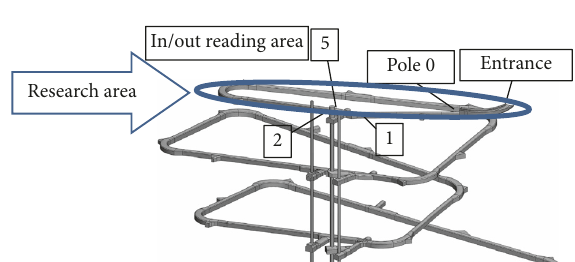
Figure 6: Research area, reading points, and reading areas in